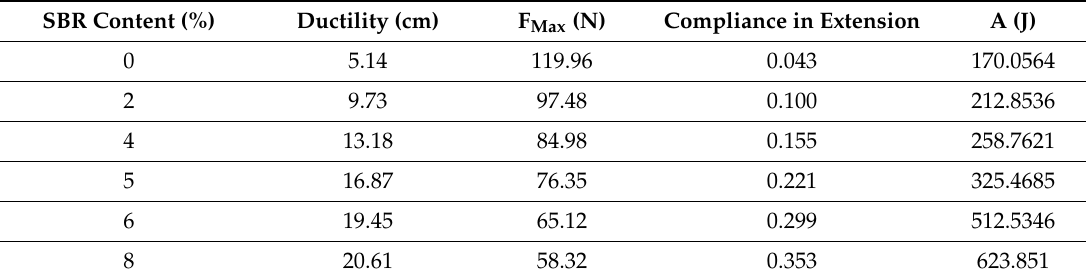
Table 14. Results of 10 ◦ C ductility test of BRA-SBR composite modified